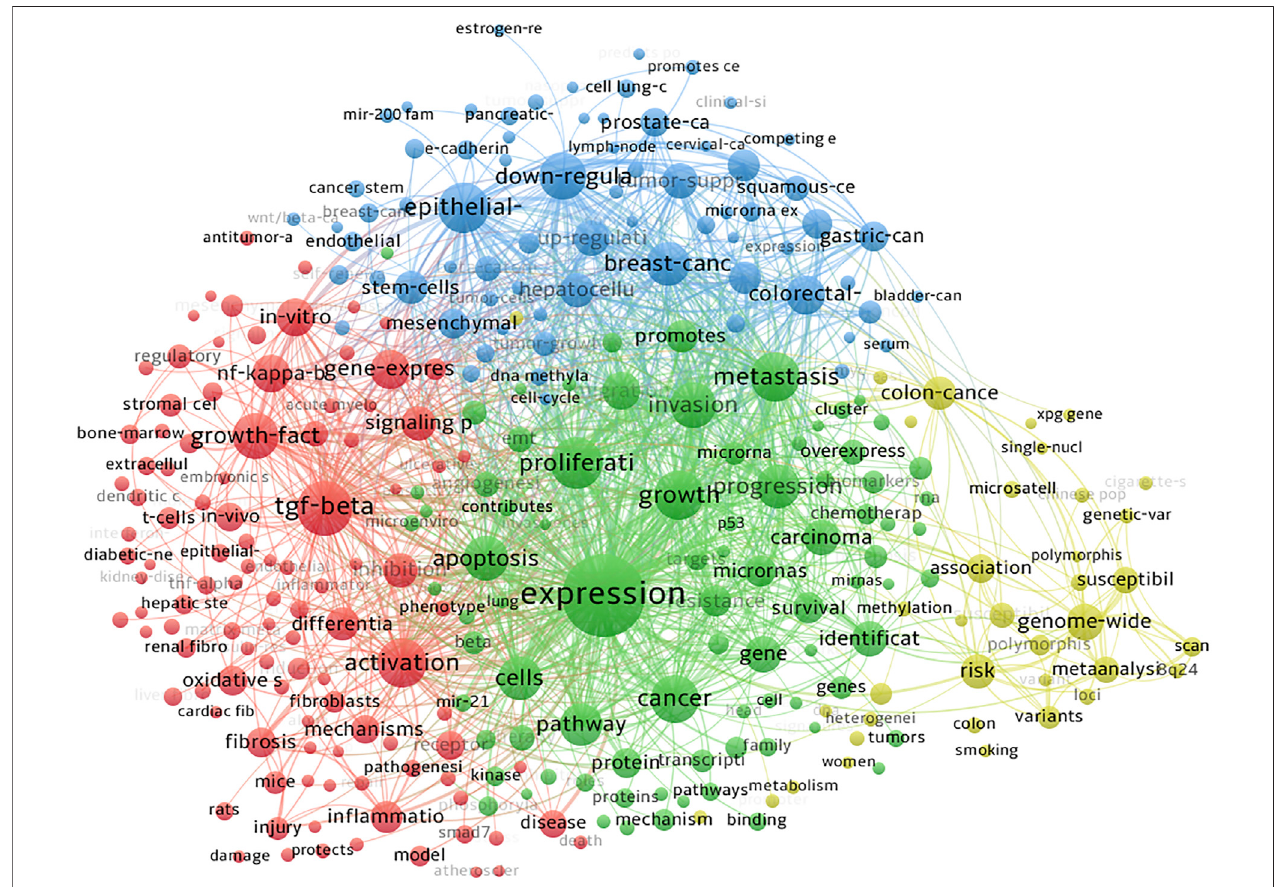
FIGURE 6 | Clustering co-occurrence map of the predominant keywords of studies on SMAD7 in oncology. Footnote: The theme words were classi fi ed into 4 clusters, presented by four colors (red, blue, green, and yellow).